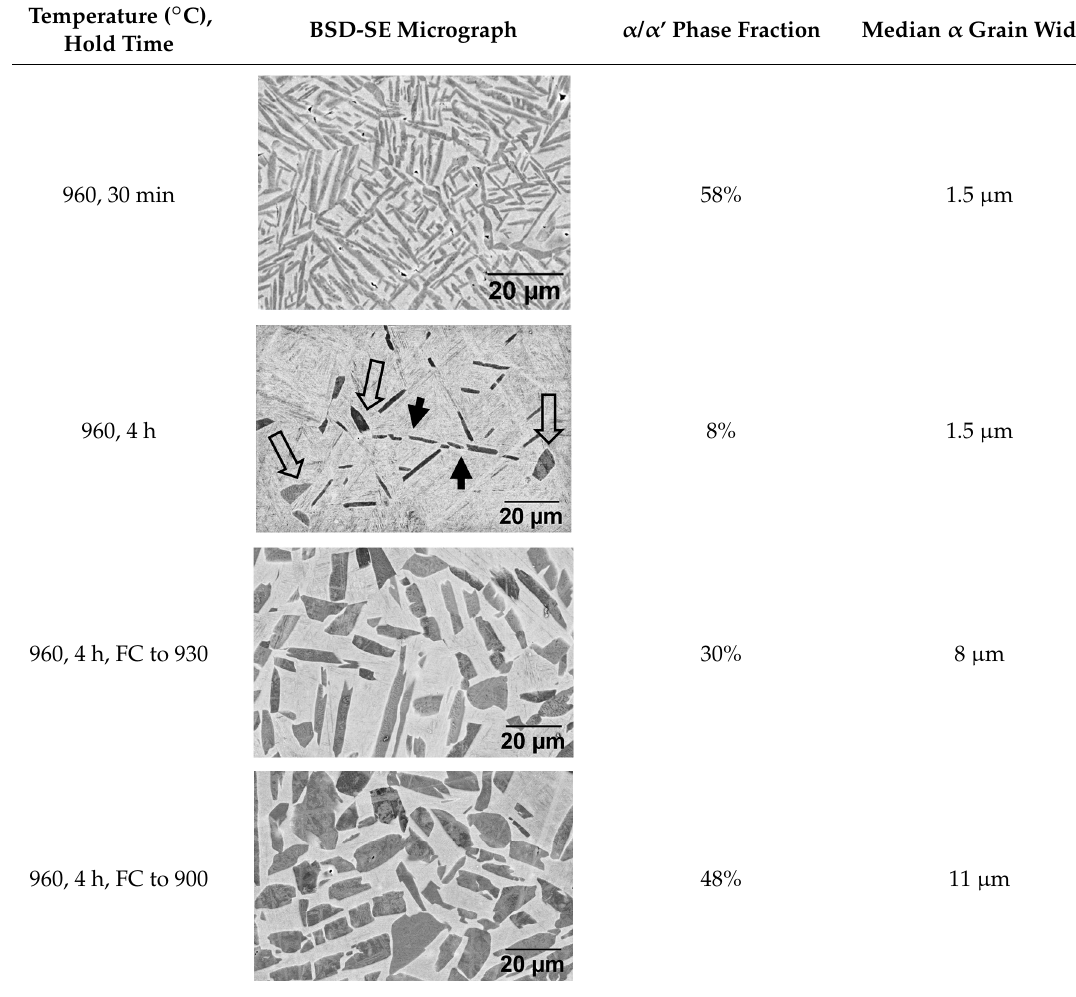
Table 8. Bi-modal microstructure summary.